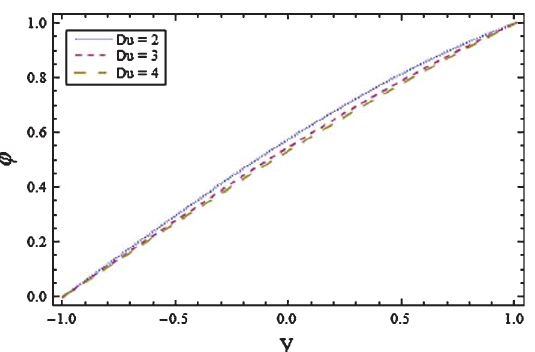
Fig. 12. Plot of concentration φ for various values of the Dufour number Du with (cid:15) = 0 . 1, x = 0 . 1, t = 0 . 1 , Sr = 2 , Sc = 2 , Pr = 1 . 2 and γ = 1 . 5 .